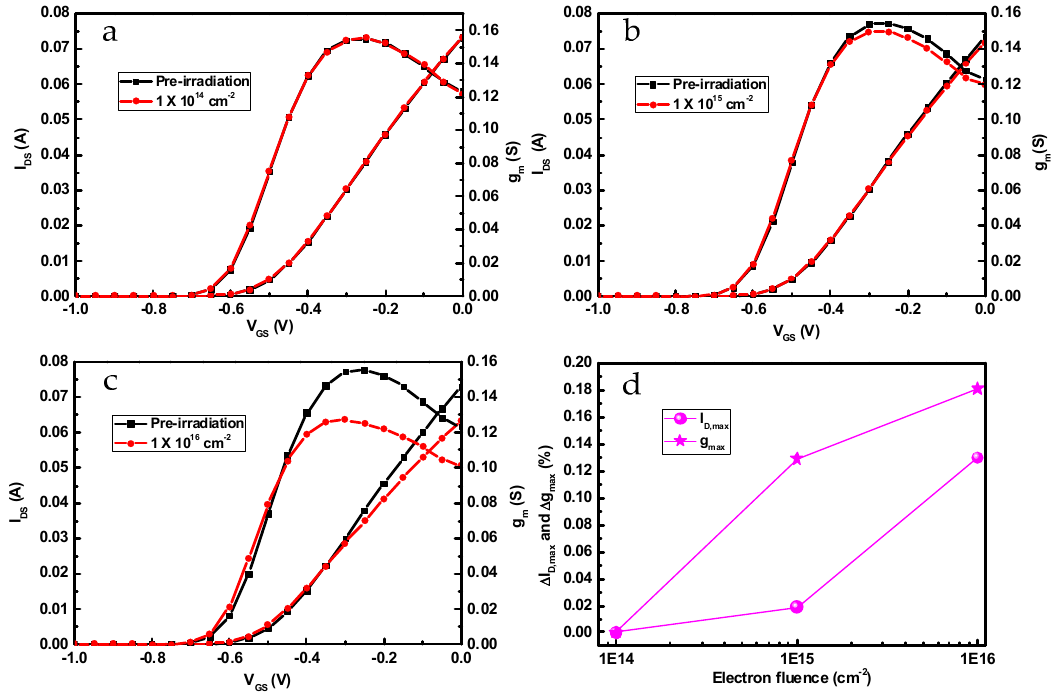
Figure 4. Transfer characteristics of InP-based HEMTs before and after 1 MeV electron irradiation with different irradiation fluences. ( a ) 1 × 10 14 cm − 2 , ( b ) 1 × 10 15 cm − 2 , ( c ) 1 × 10 16 cm − 2 , ( d ) Δ g m,max and Δ I D,max .